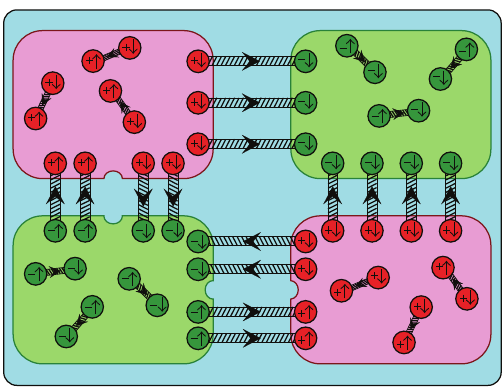
Figure 1: Representation of coherence network. Links and nodes separate puddles of merons (circles). Meron charge and electric dipole moments indicated inside circles, as are strings of overturned phase connecting meron-antimeron pairs. Reproduced from